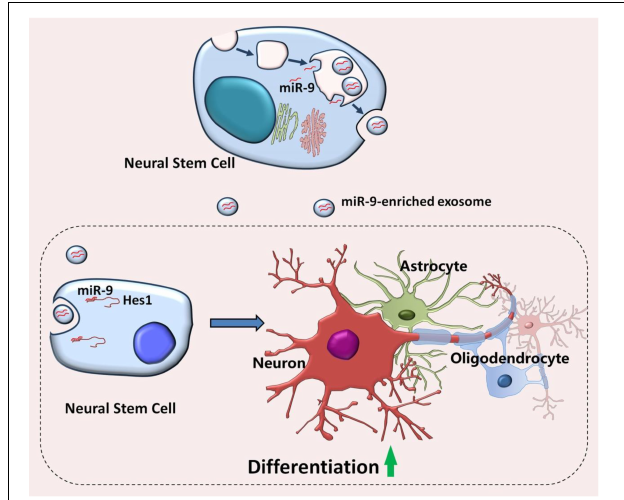
FIGURE 10 | Proposed model of EXO-mediated regulation of NSCs. Embryonic NSCs secrete exosomes enriched with miR-9. After internalizing by neighboring NSCs, exosomes release miR-9 into the recipient cells, leading to the repression of differentiation repressor gene, Hes1. The inhibition of Hes1 then facilitates the differentiation of NSCs and the maturation of both neuronal and glial cells.